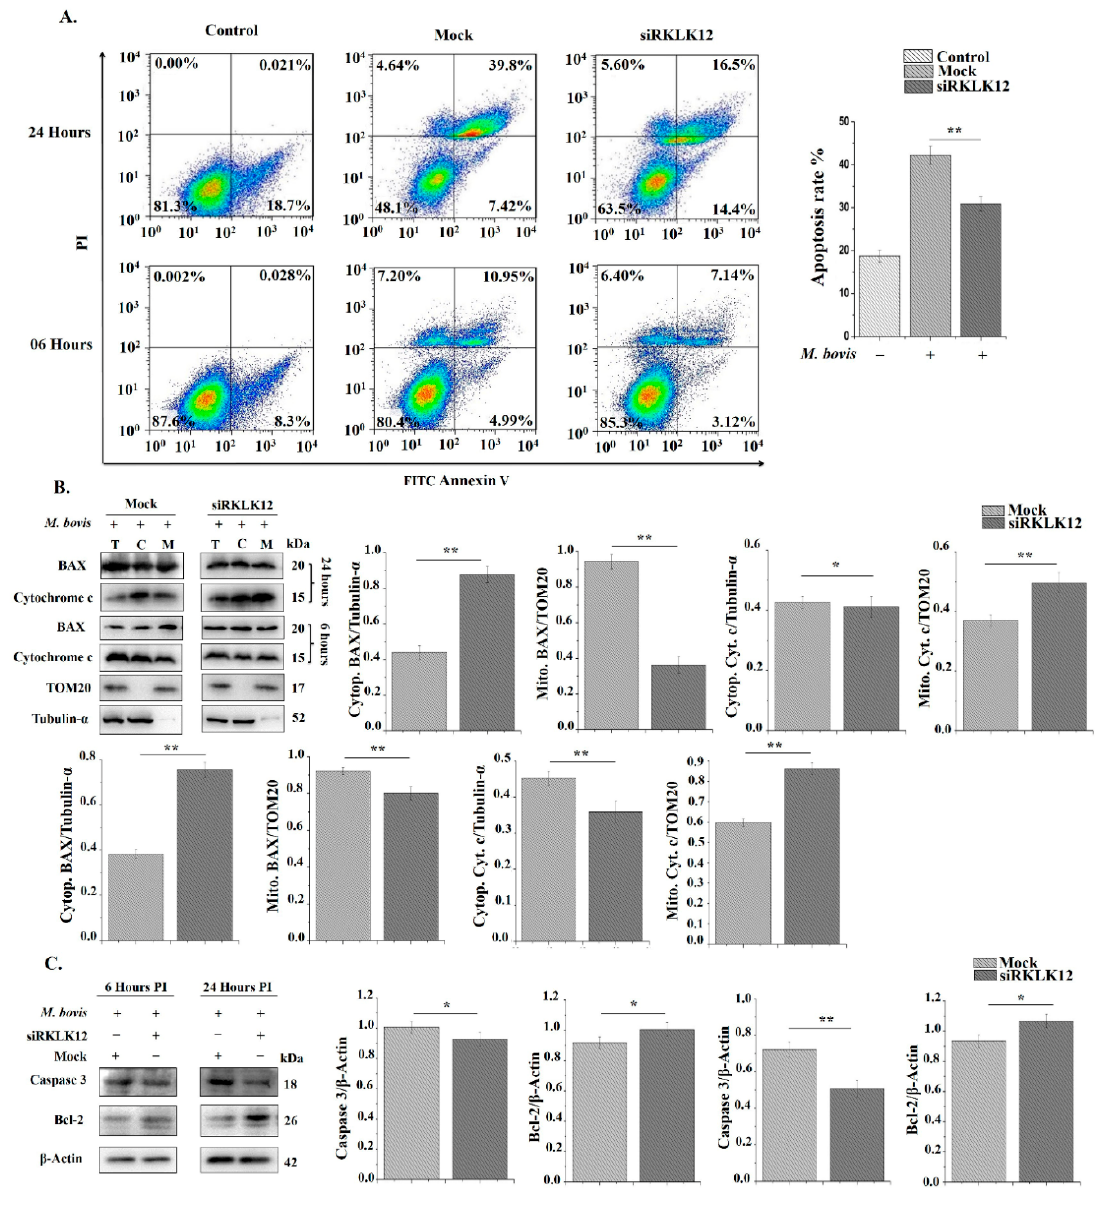
Figure 5. KLK12 regulates apoptosis in M. bovis C68004 infected murine BMDMs. ( A ) Murine BMDMs were transfected with KLK12 siRNA and negative control siRNA (20 μ M). After 48 h of